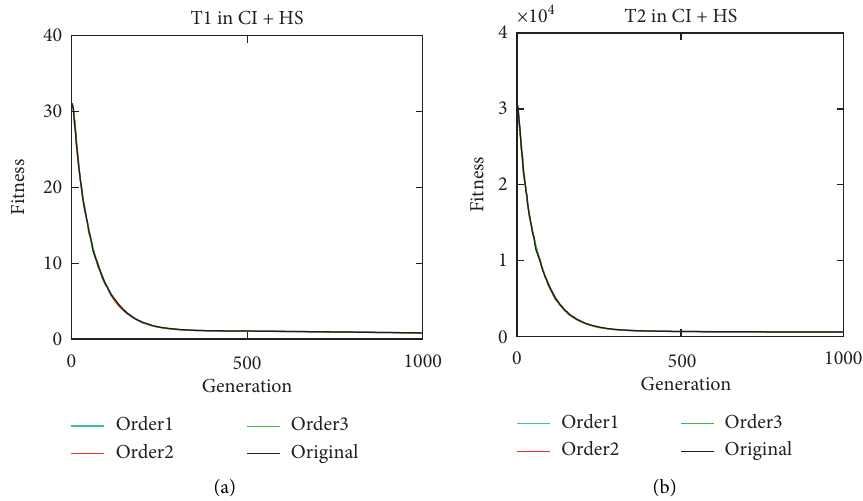
Figure 13: Convergence of MFDE for problem 1 (CI +HS).